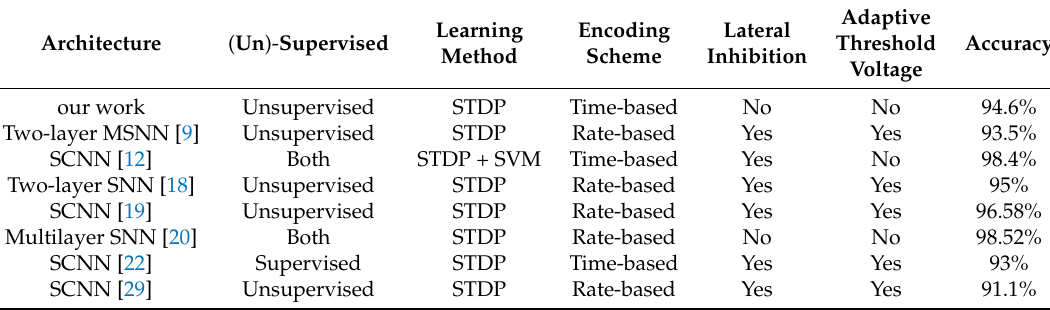
Table 2. Comparison with previous